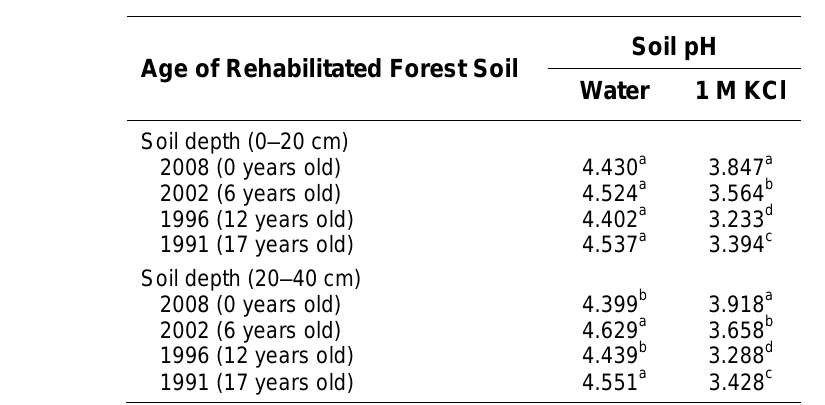
pH of a Rehabilitated Forest Soil (Different Ages)